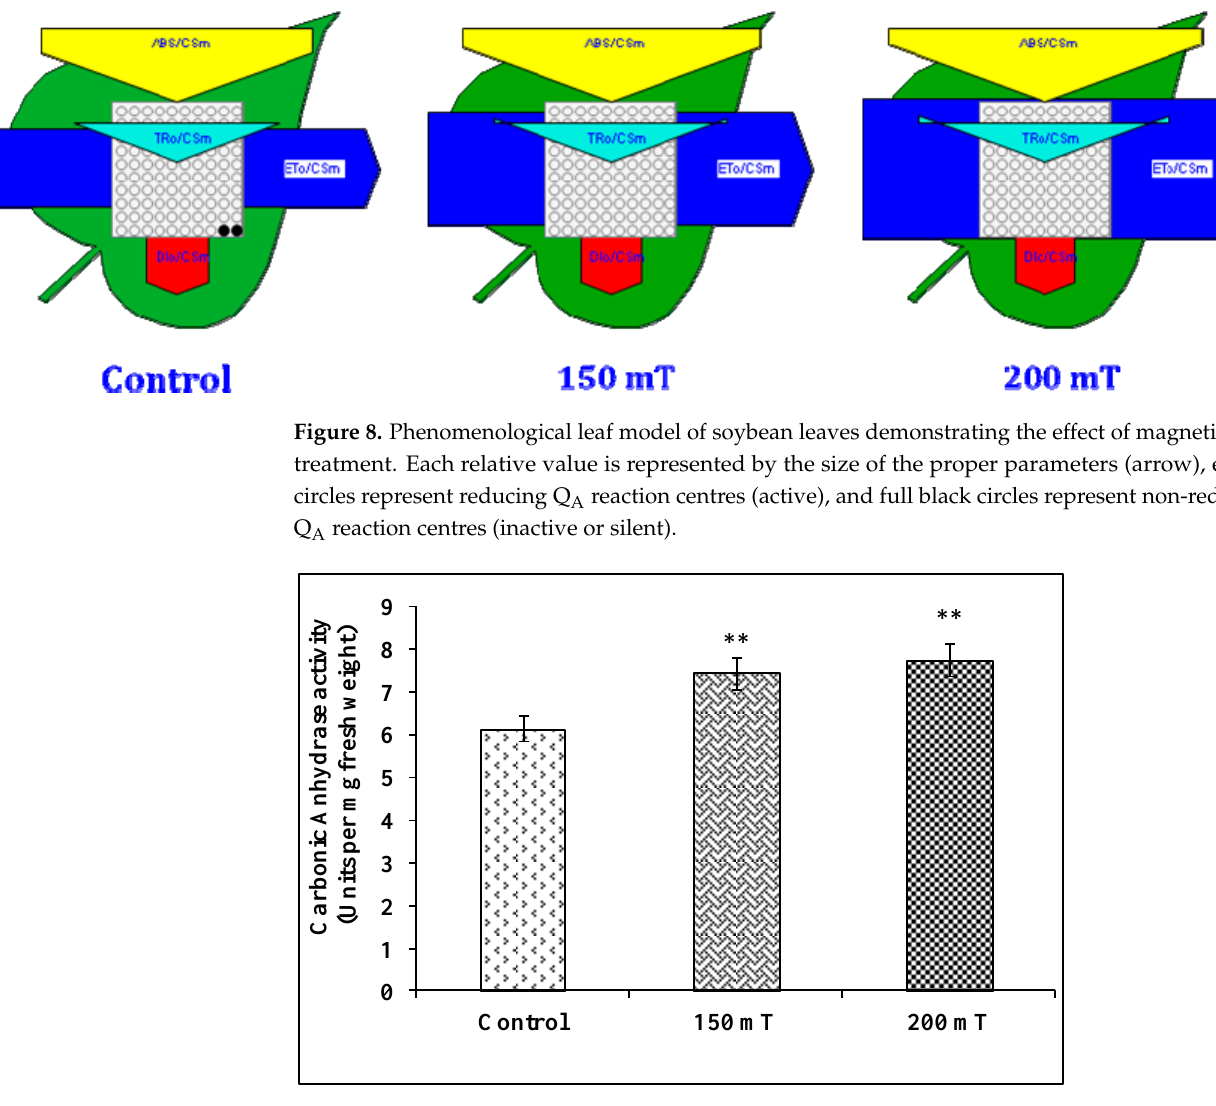
Figure 9. Effect of pre-sowing magnetic field treatmentof soybean seeds on carbonic anhydrase ac- tivity. ** indicates significance at p < 0.01 compared to control.